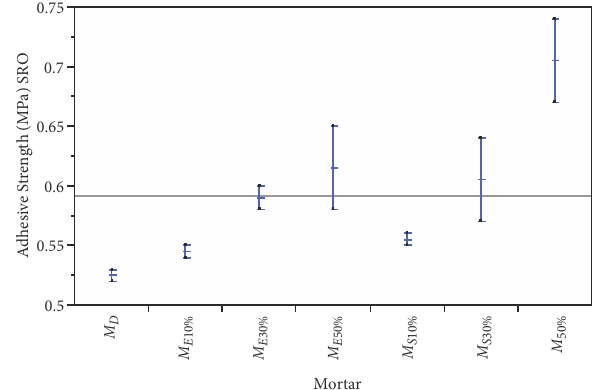
Figure 8. LSD range of the mean adhesive strength of hardened mortar for the seven mortar types tested with various replacement levels